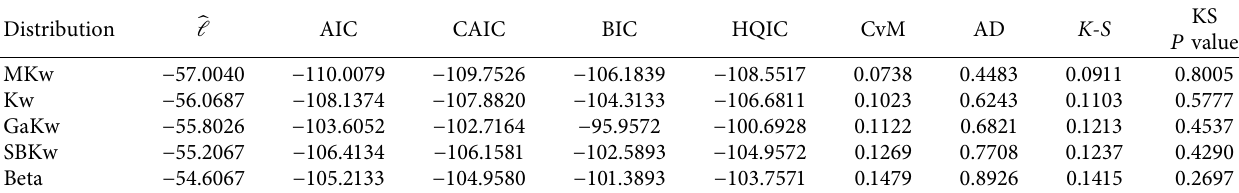
Table 12: Te statistics AIC, CAIC, BIC, HQIC, CvM, AD, and K - S for data set